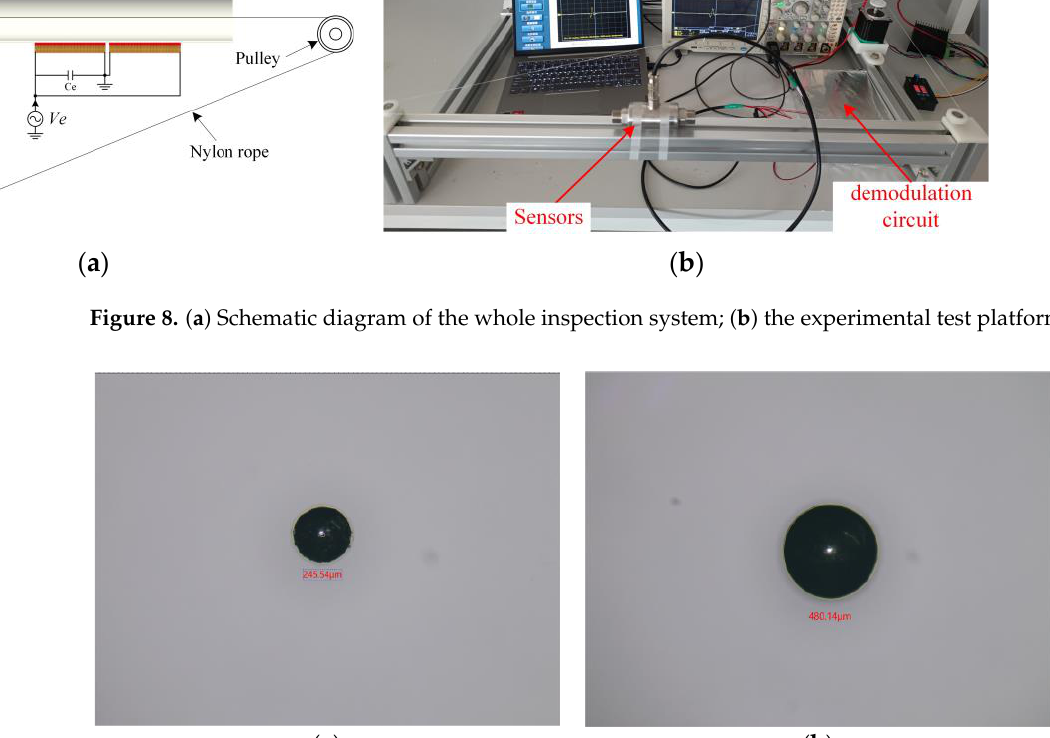
Figure 9. The microphotograph of iron particles. ( a ) 245 μm ; ( b ) 480 μm .